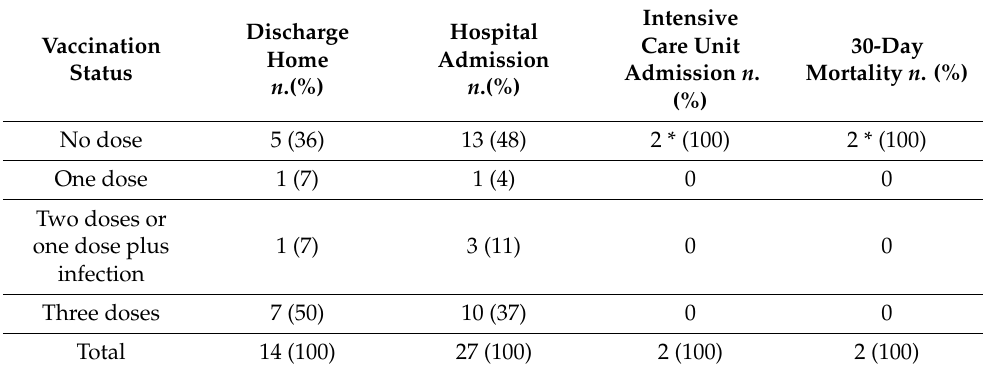
Table 1. Vaccination status and patient management after Emergency Department